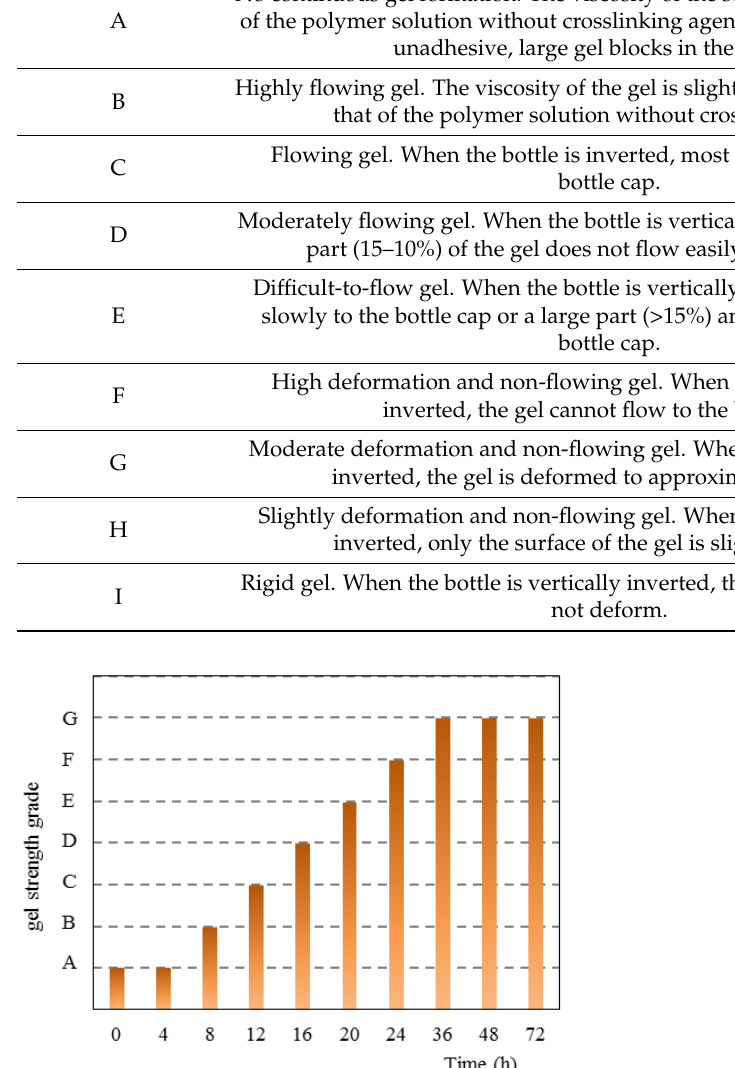
Figure 5. SEM image of polymer gel. 3.2. Polymer Microsphere Properties Polymer microspheres were prepared using injection water with a concentration of 3000 mg/L. The appearance and particle sizes of the polymer microspheres are shown in Figure 6 and Table 4, wherein the hydration and expansion abilities of the polymer micro- spheres can be observed. The initial particle size distribution had a range of 7.2–11.1 μm. With an increase in the hydration time, the particle size of the polymer microspheres grad- ually increased. The particle size increased quickly in the initial stage and gradually in the later stage. The hydration expansion particle size range was 40.6–48.3 μm after 7 days,